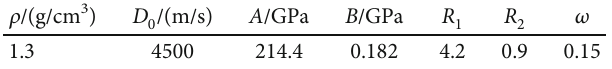
Table 3: Explosive materials and state equation